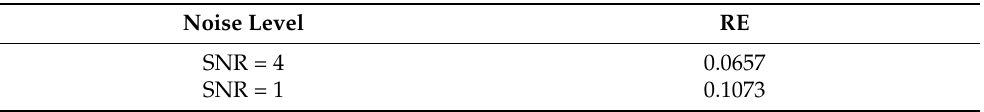
Table 2. The REs of inverted reflectivity series by ENRI performed on noise-contaminated syn- thetic